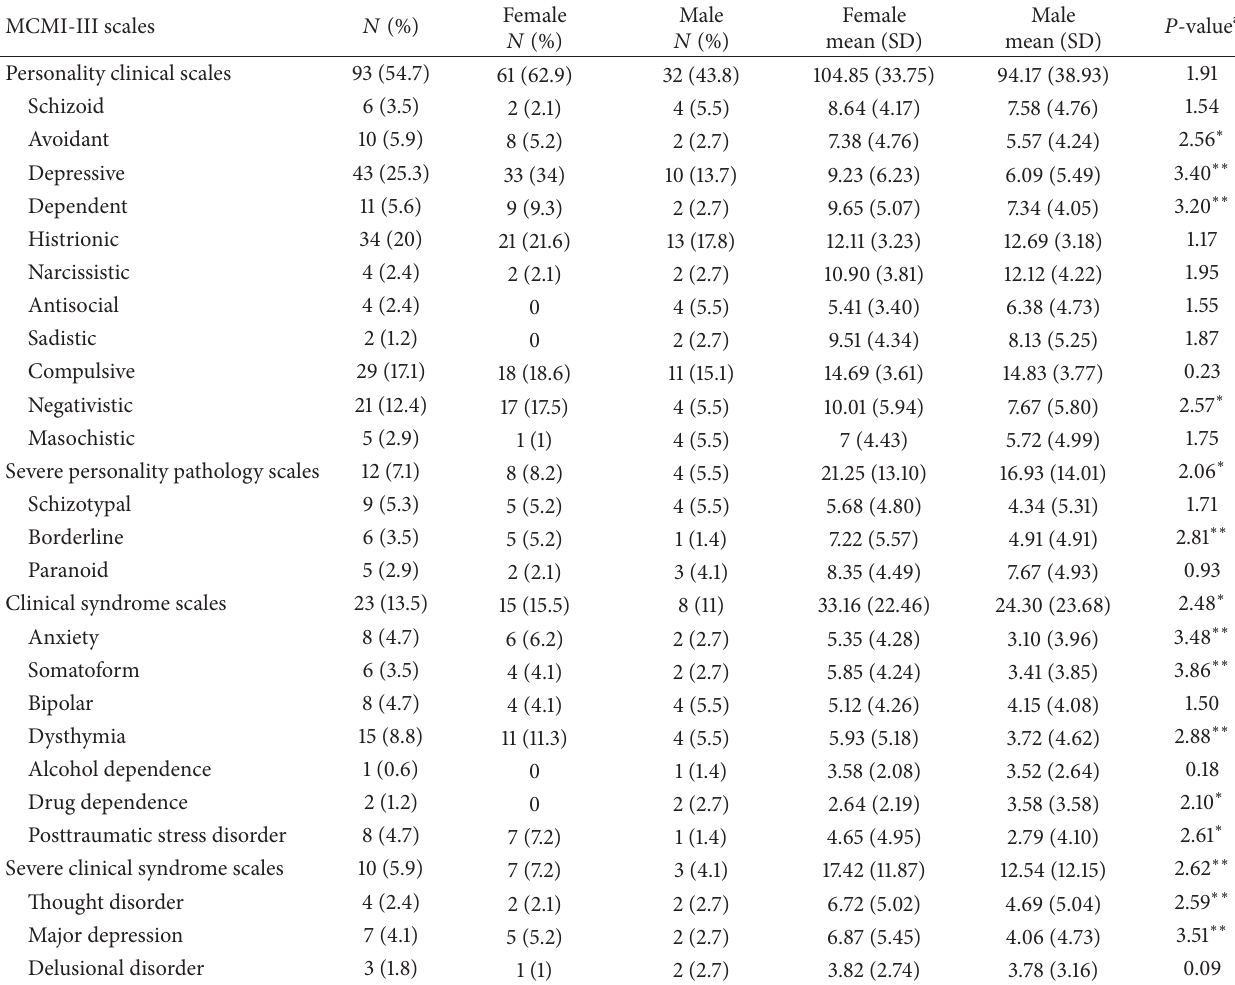
Table 1: Prevalence of personality disorders of parents of ADHD and 𝑡 -test result of personality comparison between male and